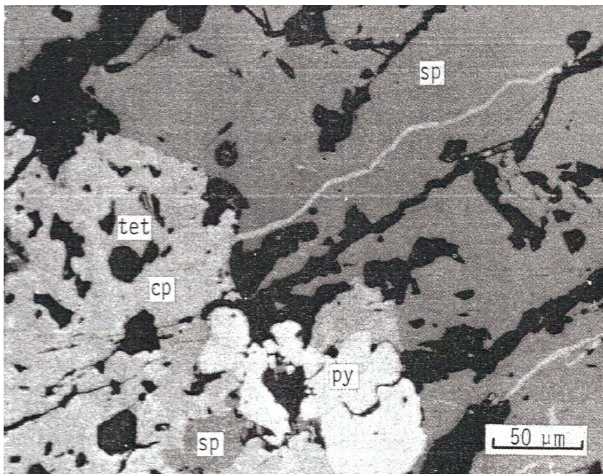
Fig. 3. Micrograph of massive sulphide ore in Pulacayo Mine (from Villalpando and Ueno, 1987). Ore minerals are sphalerite (sp), tetrahedrite (tet), chalcopyrite (cp) and pyrite (py).